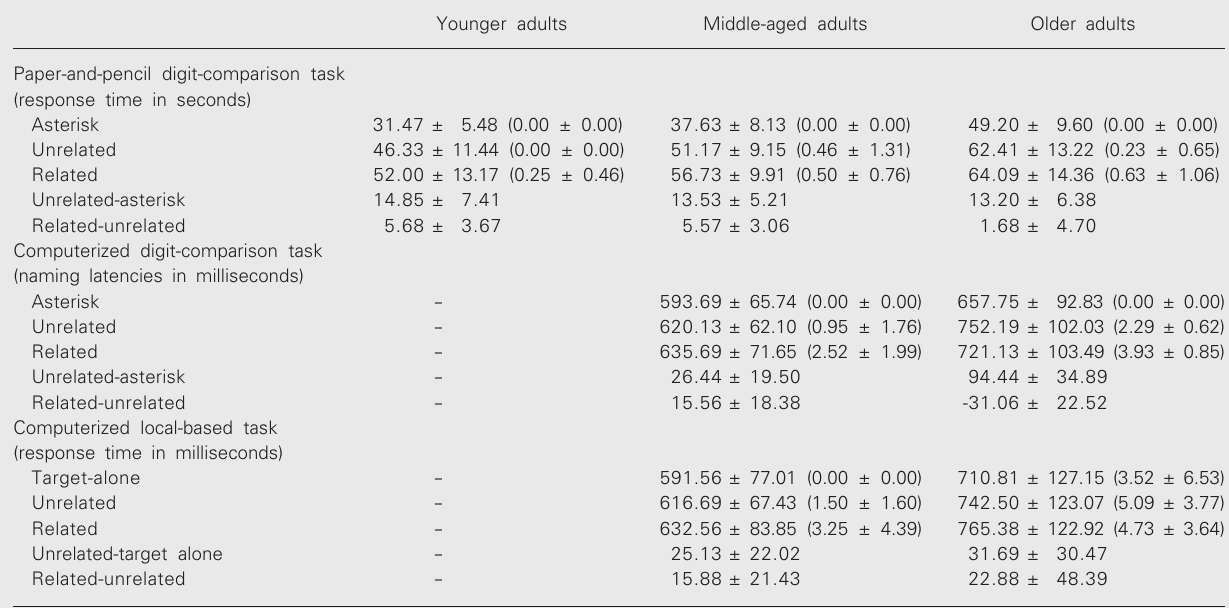
Table 2. Response time and errors for conditions across tasks by age groups in Experiment